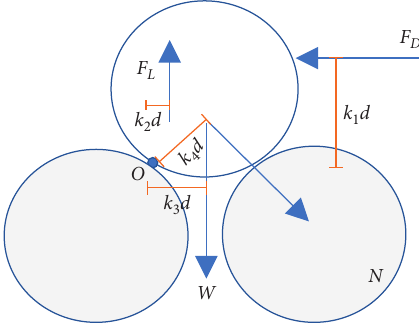
Figure 2: Stress analysis of cement particles. Table 1: Numerical table of normal distribution